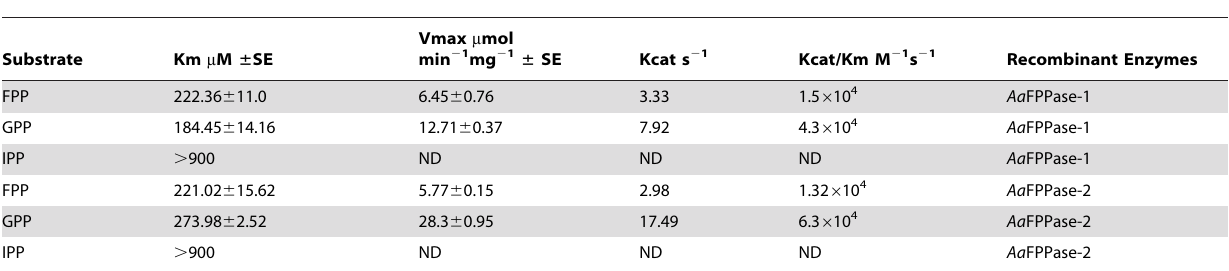
Table 1. Substrate specificity for Aa FPPase-1 and Aa FPPase-2.